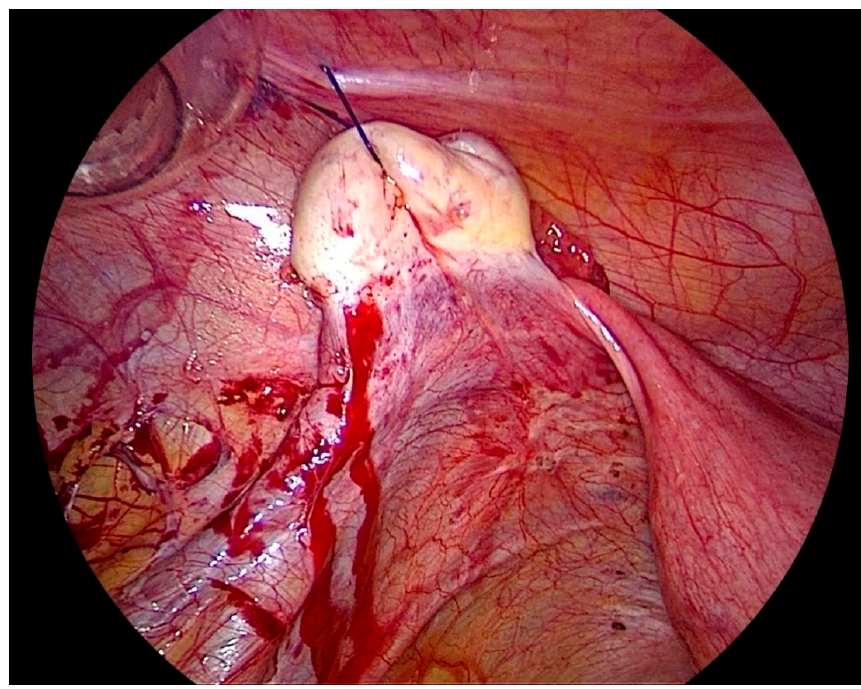
Figure 2. Laparoscopic view of the lateral pelvic wall on the left side after ovariopexy with endometriosis easily visualized and accessible.